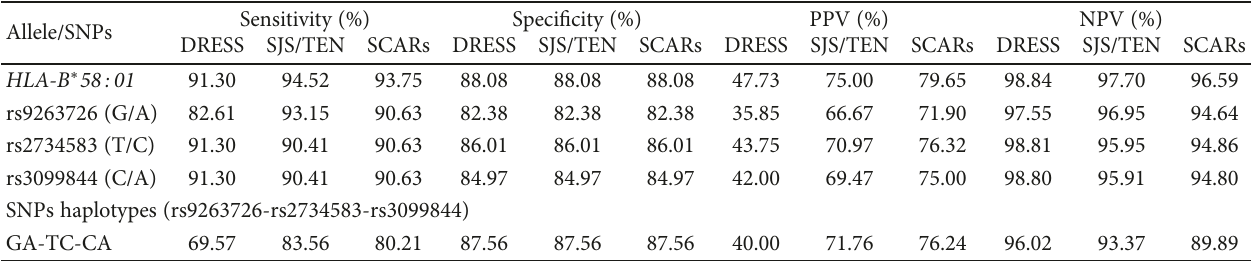
Table 3: Properties of proposed genetic screening tests for prediction of allopurinol-induced SCARs in a Thai population. Sensitivity (%) Speci fi city (%) Allele/SNPs DRESS SJS/TEN SCARs DRESS SJS/TEN SCARs DRESS SJS/TEN SCARs DRESS SJS/TEN SCARs